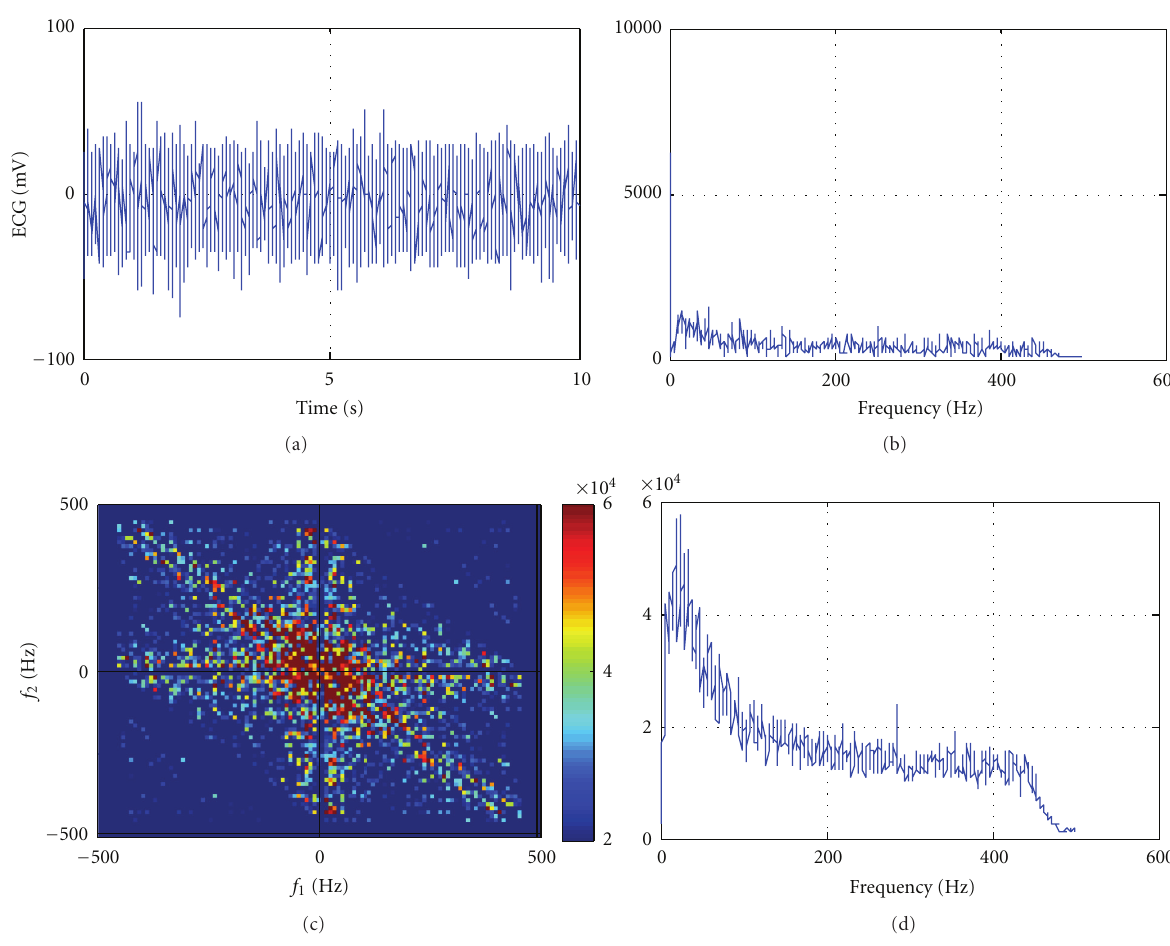
Figure 1: (a) The EMG activity of normal action, (b) its power spectrum, (c) its bispectrum, and (d) its bispectrum in 2